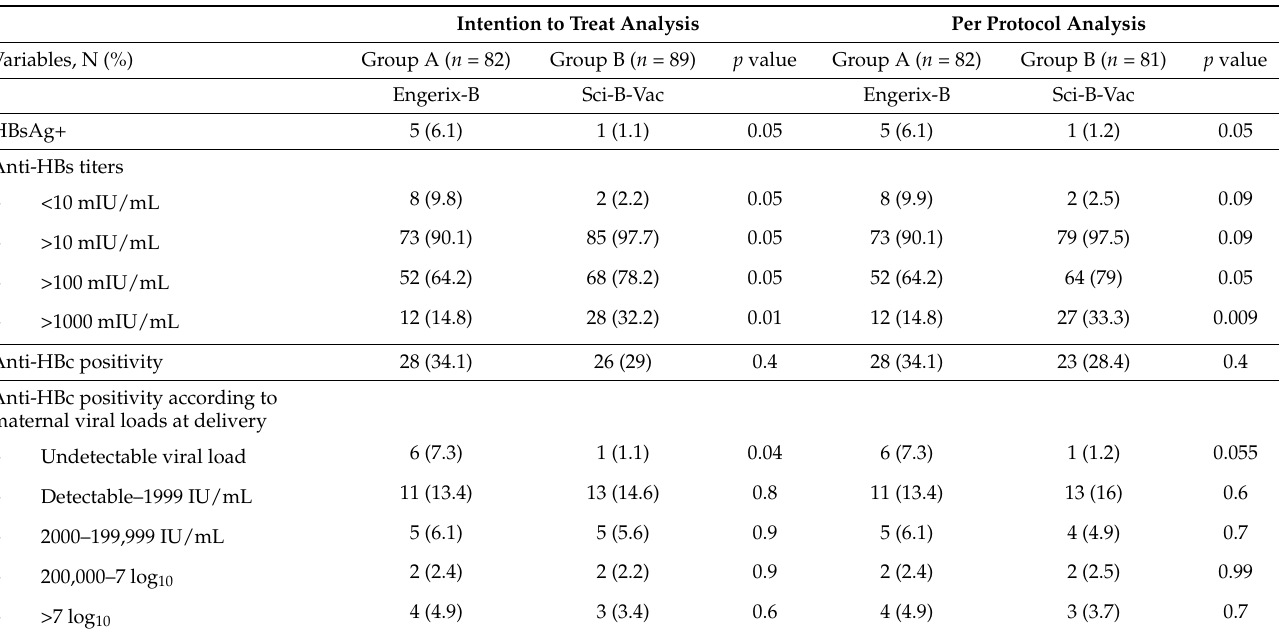
Table 3. Neonatal characteristic in regard to HBV status. Intention to Treat Analysis Per Protocol